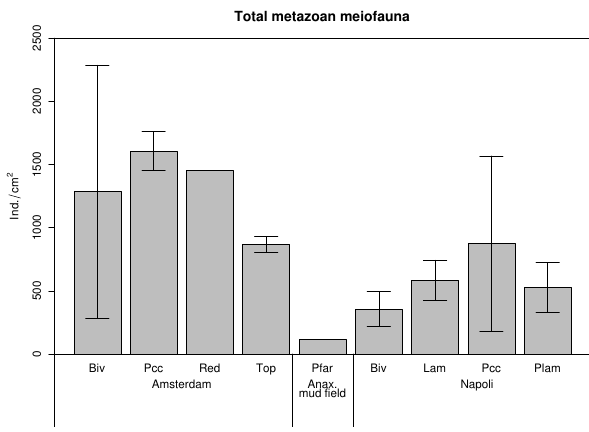
Fig. 2. Total metazoan meiofauna (individuals per 10cm 2 ) per mi- crohabitat (Biv: bivalve shells; Pcc: periphery of carbonate crusts; Red: reduced sediments; Top: summit of the mud volcano; Lam: Lamellibrachia microhabitat; Plam: periphery of Lamellibrachia ; Pfar: far